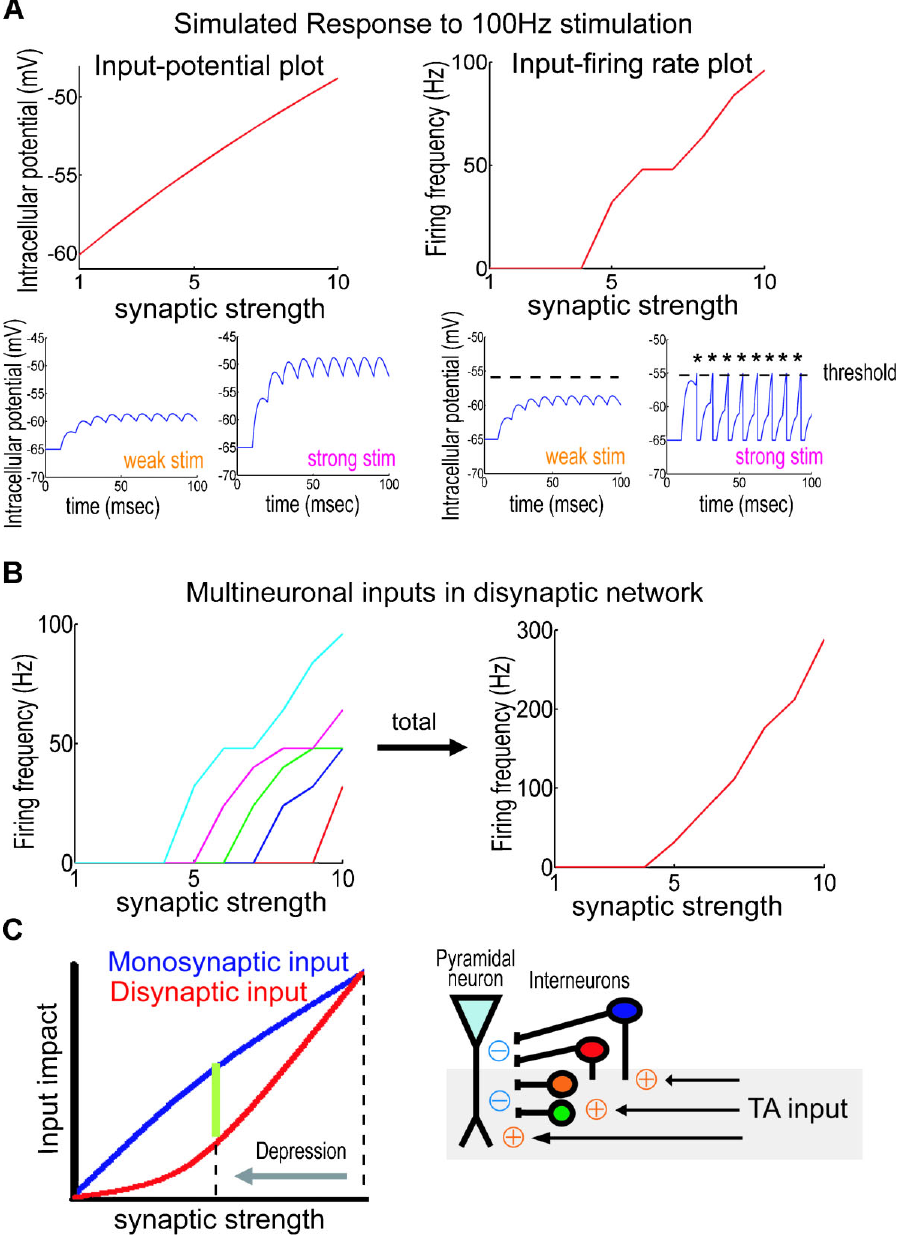
Figure10. Modulationofexcitatory/inhibitorybalancebyDA-inducedexcitatorydepression .( A )Simulationbasedonanintegrate-and-firemodel.Excitatory stimuli at 100Hz are delivered using EPSPs of different initial strengths. Each plot shows either maximal membrane potential (left) or firing frequency (right) to a given initial input strength. During monosynaptic transmission, maximum membrane potentials depend approximately linearly on input strength (left). Disynaptic transmission, on the other hand, requires action potential generation for the signal propagation, which imposes a nonlinear dependency on input strength (right). ( B ) Total signal output from multiple neurons. Each neuron has a different threshold-level as plotted in different colors (left). Summated output depends nonlinearly on input synaptic strength (right). Similarly, at TA-CA1 synapses, a pyramidal neuron receives disynaptic inhibition from multiple number of interneurons, thus inhibition evoked by the TA pathway should nonlinearly depend on the input synaptic strength. ( C ) Differential influence of synaptic depression between monosynaptic and disynaptic transmission. After depression of TA-CA1 synaptic transmission, the reduction of disynaptic inhibition is larger than that of monosynaptic excitation, explaining why the synaptic efficacy is enhanced during HFS, as observed as high-pass filtering, under the DA-induced excitatory depression. Other interneuron classes not studied here may be similarly affected by